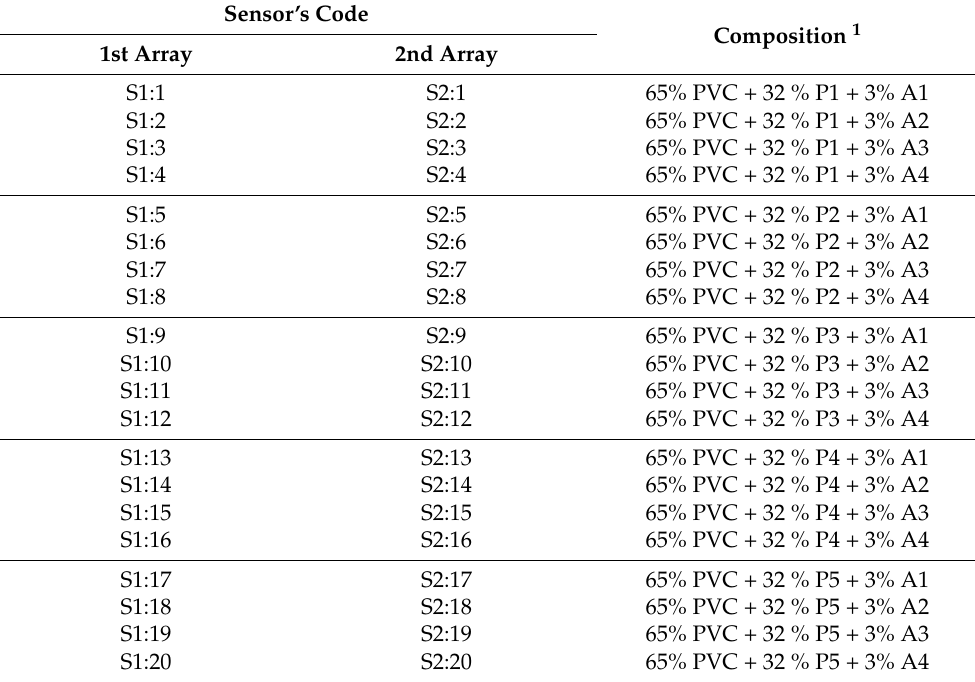
Table 1. Lipid sensor membranes of the lab-made E-tongue: codes and composition. Sensor’s